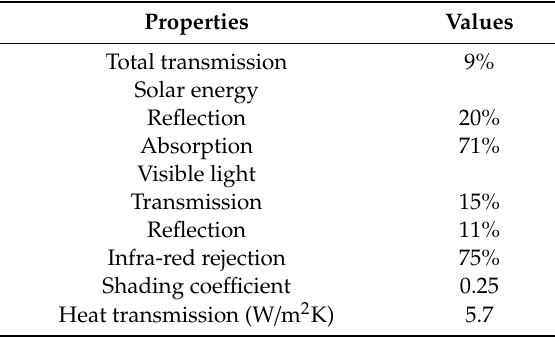
Table 1. Properties of existing solar control film in north-west façade.